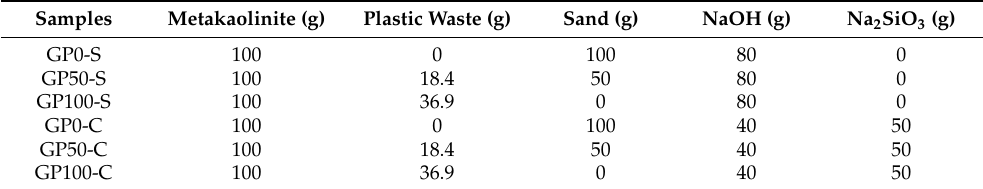
Table 1. Dosage of materials for the production of the mortars GP-S and GP-C with 0, 50, and 100% replacement levels of sand with plastic